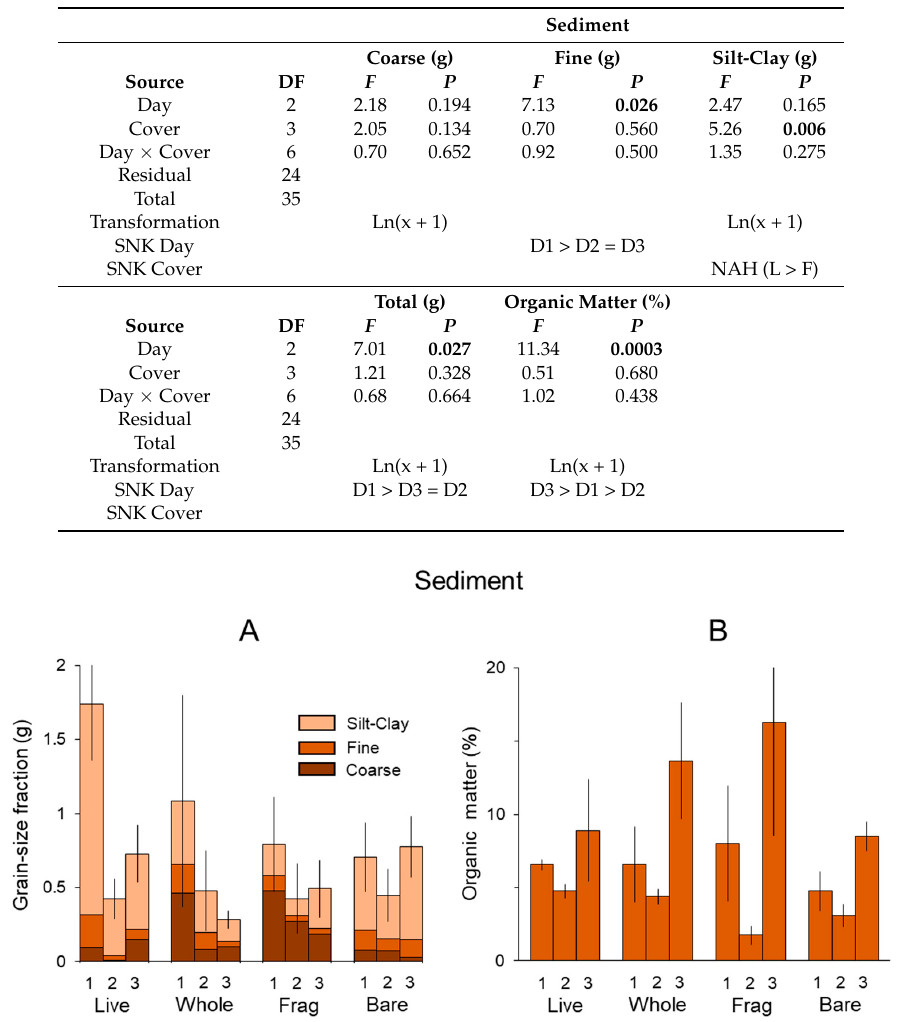
Table 1. ANOVA results for sediment in traps: mass values and percent total organic material. Transformations indicated where applied. Significant differences ( P < 0.05) are in bold and Student-Newman-Keuls (SNK) results are presented. NAH = no alternative hypothesis; the two